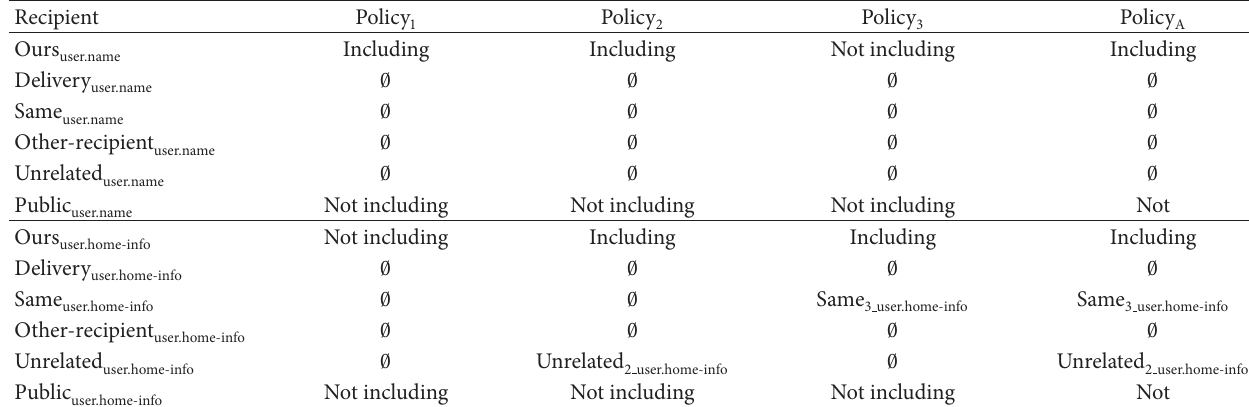
Table 1: Recipient values of Data elements in Service A.